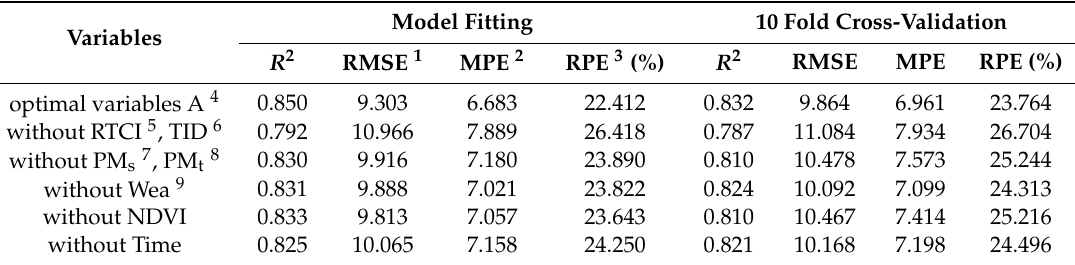
Table 1. Model validation using Sample set A.